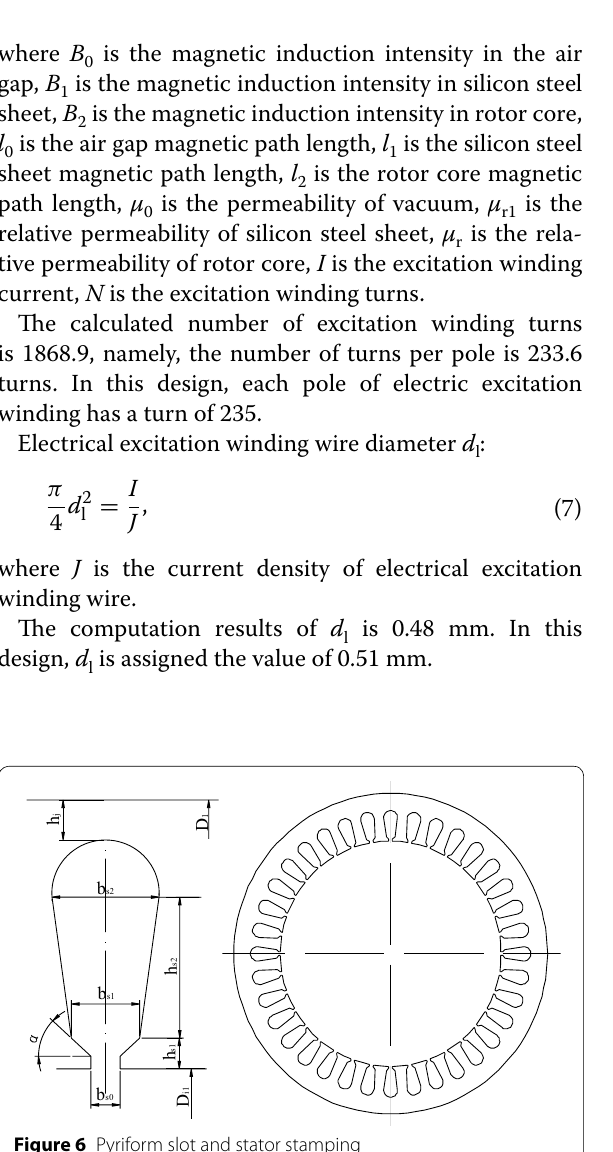
Figure 8 Fractional slot winding schematic